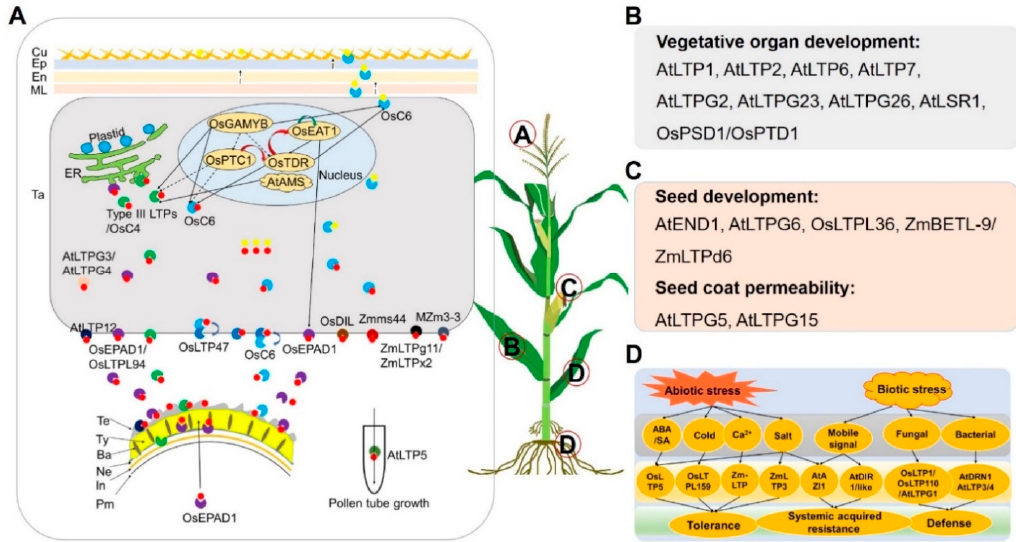
Figure 4. The main functions of LTP transporters in Arabidopsis , rice, and maize. ( A ) The proposed working model of LTP transporters involved in anther and pollen development. Several LTPs transfer tapetum-generated lipidic and other precursors for anther cuticle and pollen wall development, and AtLTP5 is required for the apical accumulation of reactive oxygen species in growing pollen tubes. Ba, baculum; Cu, cuticle; Ep, epidermis; En, endothecium; In, intine; ML, middle layer; Ne, nexine; Pm, plasma membrane; Ta, tapetum; Te, tectum; Ty, tryphine. ( B , C ) LTP genes participate in vegetative organ or seed development and seed coat permeability in Arabidopsis , rice, and maize. ( D ) Regulation of plant resistance by LTP transporters in response to biotic and abiotic factors. The stress factors, LTP transporters, and their corresponding substrates and physiological roles in plants are displayed in ( D ). ABA, abscisic acid; SA, salicylic acid. A–D in red circle represent the mainly expression position of the genes in A to D, respectively.